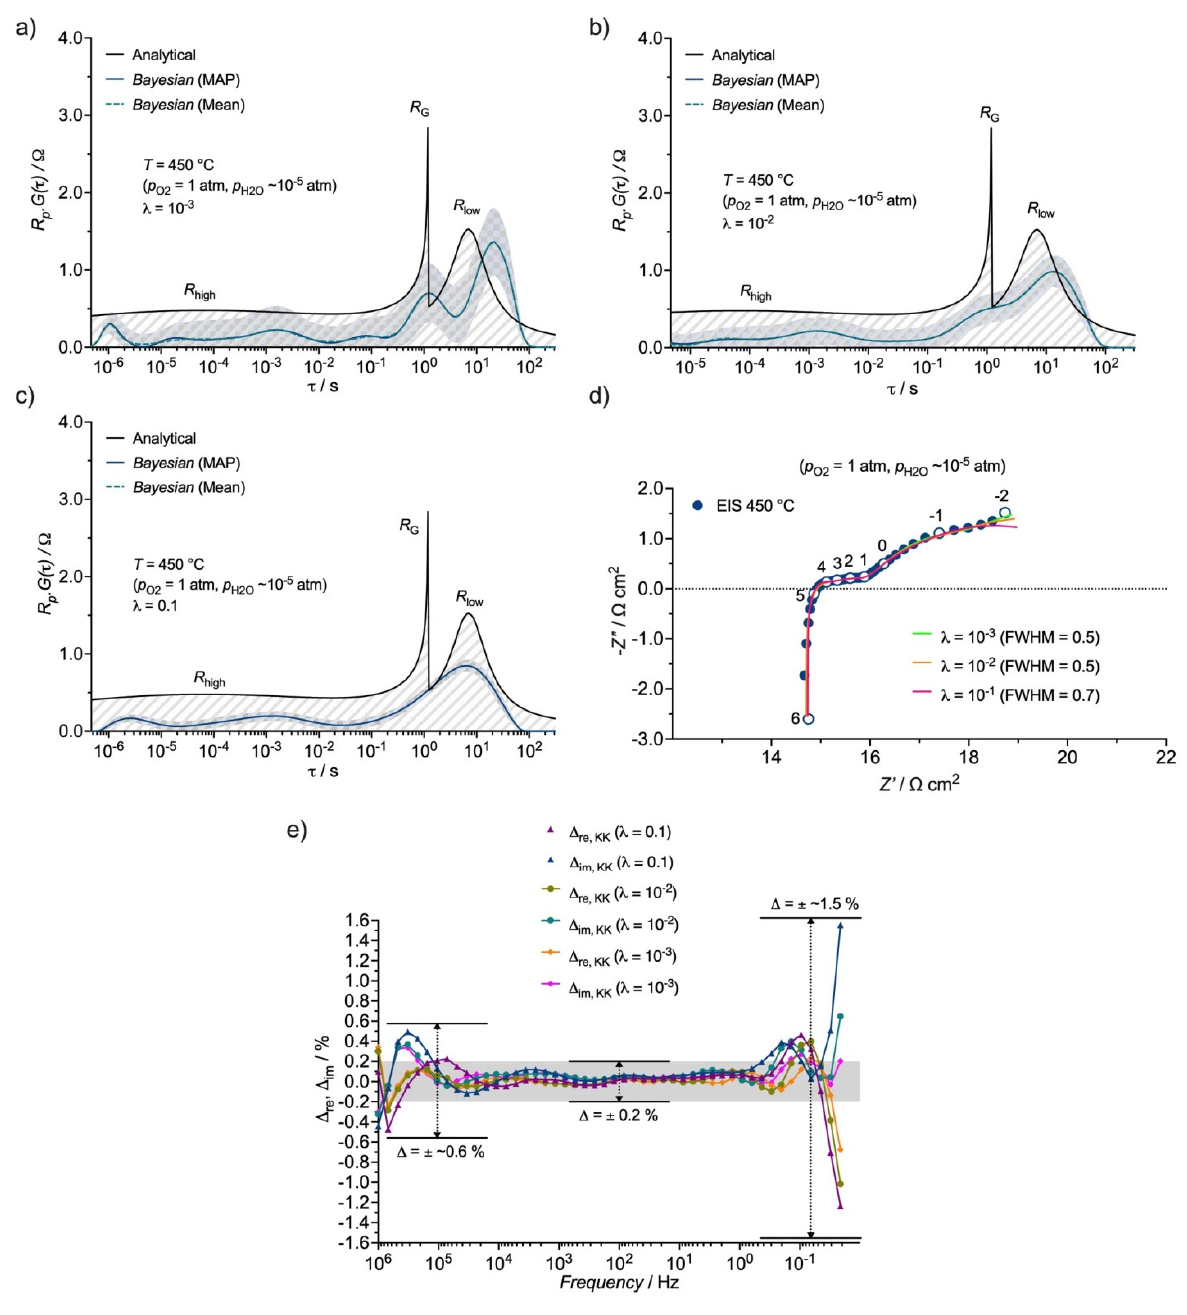
Figure 7. DFRTs obtained from the Bayesian regularisation of the EIS data obtained in low humidity ( p H2O ~ 10 − 5 atm) conditions at 450 °C in O 2 atmosphere (the 99% credibility interval is presented in the shadow area around the Bayesian curves) for different regularisation parameters: ( a ) λ = 10 − 3 , ( b ) λ = 10 − 2 , ( c ) λ = 0.1 (FWHM is the full width at half maximum). The reconstructed impedances are plotted together with the original EIS data in ( d ), and the respective residuals in ( e ).